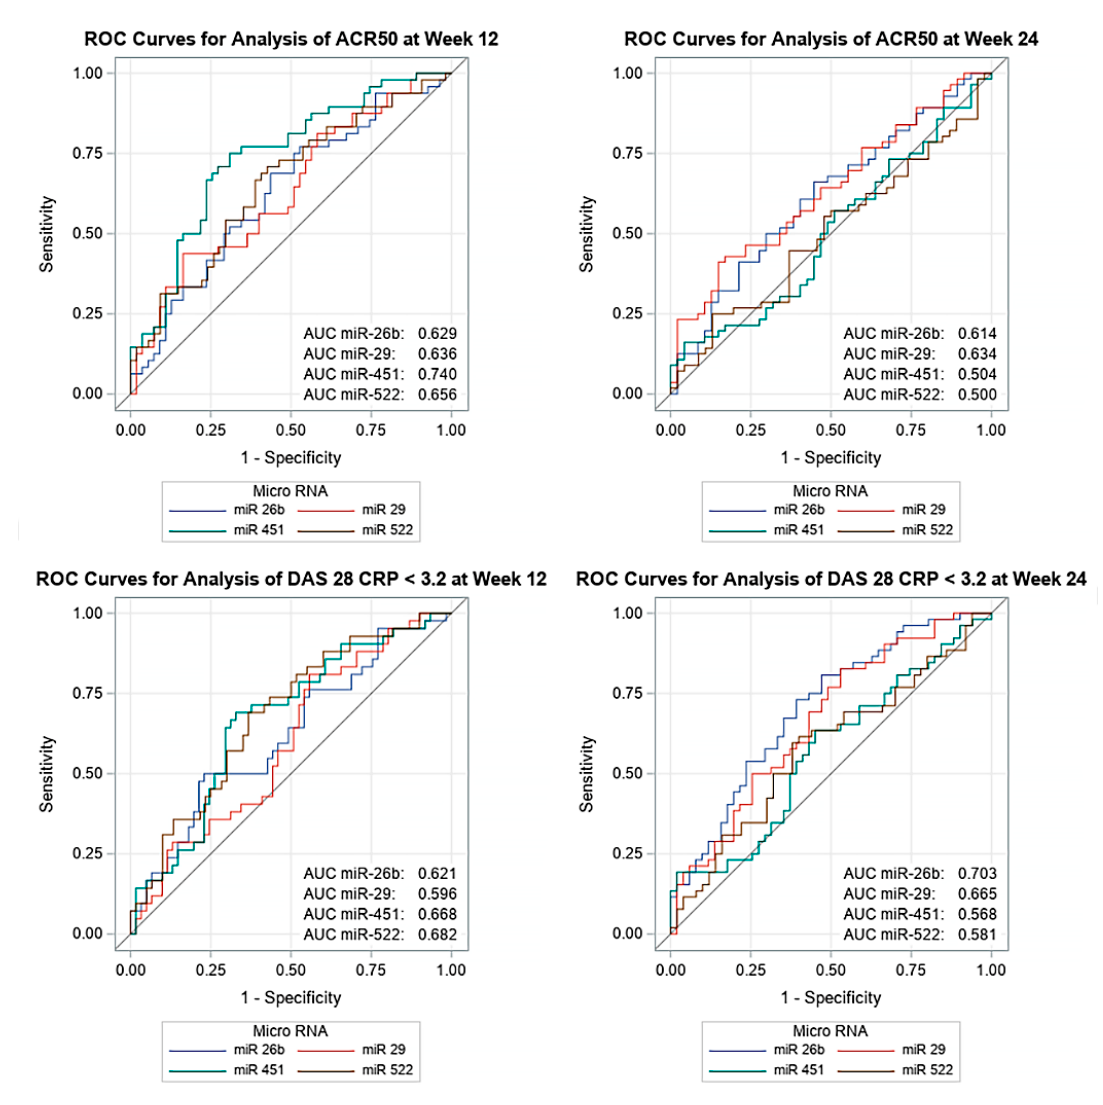
Figure 1. Associations between miRNAs miR-26b, miR-29, miR-451, miR-522 and ARC50, DAS28. The receiver operating characteristic (ROC) curves.